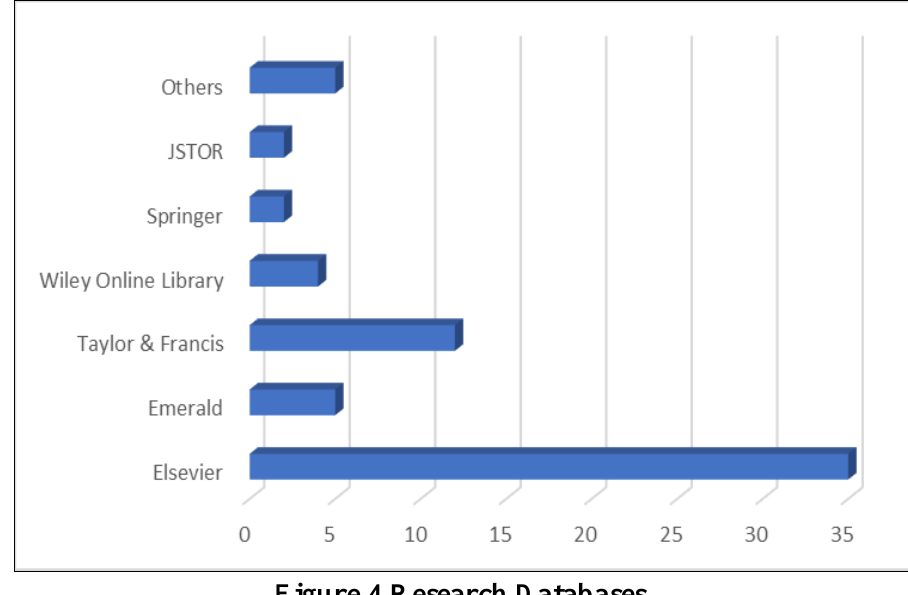
Figure.4.Research